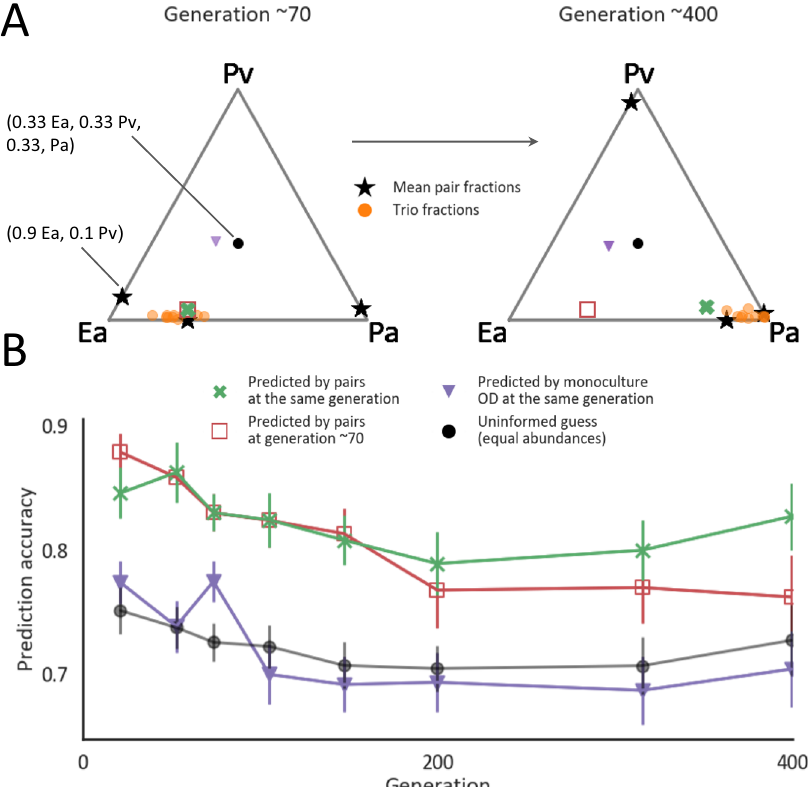
Fig. 4 Changes in composition that occur in three-species communities are well predicted by those that occur in two-species communities. A An example predicting the composition of one community at ecological and evolutionary timescales. The trio and the pairwise compositions of the three- species community Ea-Pa-Pv at generation ~70 and ~400. Each triangle is a simplex denoting the fractions of the three species, where each node is a speci fi c species. The black stars on the edges denote the mean fractions in pairwise competition, the orange dots are the compositions of each of the trio replicates. The green cross is the predicted trio composition by pairs at the same generation and the red square, purple triangle, and black dot are predictions made by pairs at generation ~70, species mean carrying capacities at the same generation, and the best-uninformed guess (which means that p the species fractions would all be 1/3) respectively. B The accuracy of prediction as 1 (cid:3) Δ ð prediction ; observation Þ ffiffi ffiffiffi p n Euclidean distance between the prediction and the observation and n is the largest possible distance between two communities with the same n species (here n = 3). Colored markers indicate the mean prediction accuracies of the predictions exempli fi ed in ( A ), error bars indicate standard errors of 23 trios, and connecting lines help to visualize but do not have a biological meaning. Only trios composed of pairs whose evolutionary trajectories were measured were included in the analysis. Source data are provided as a Source Data fi